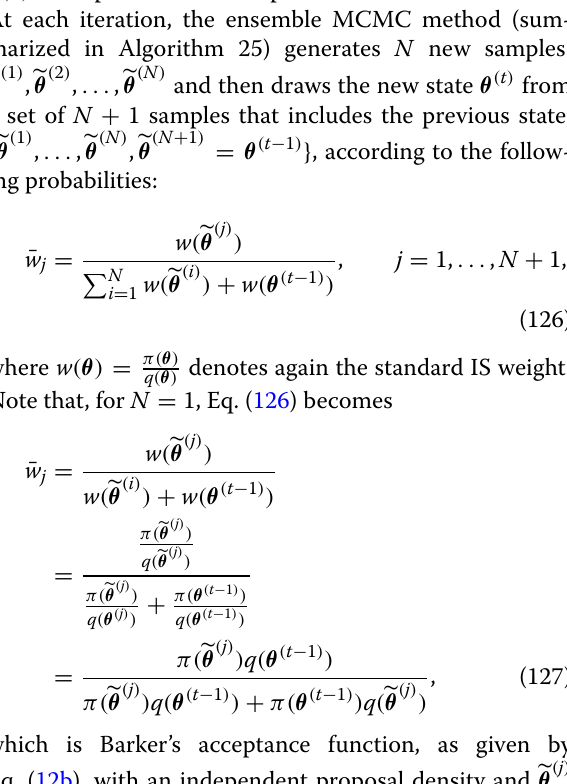
Algorithm 25 Ensemble MCMC with an